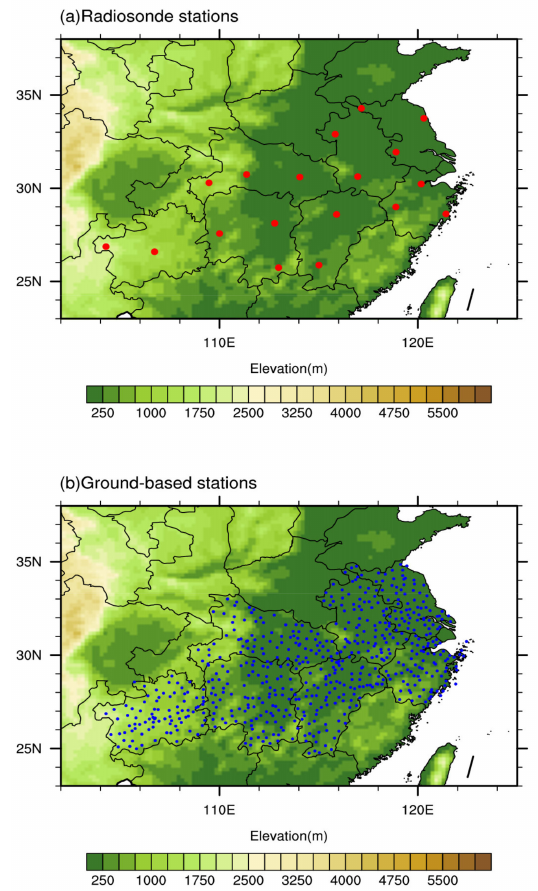
Figure 1. The distribution of radiosonde stations (top panel, red dots) and ground-based stations (bottom panel, blue dots) in southern